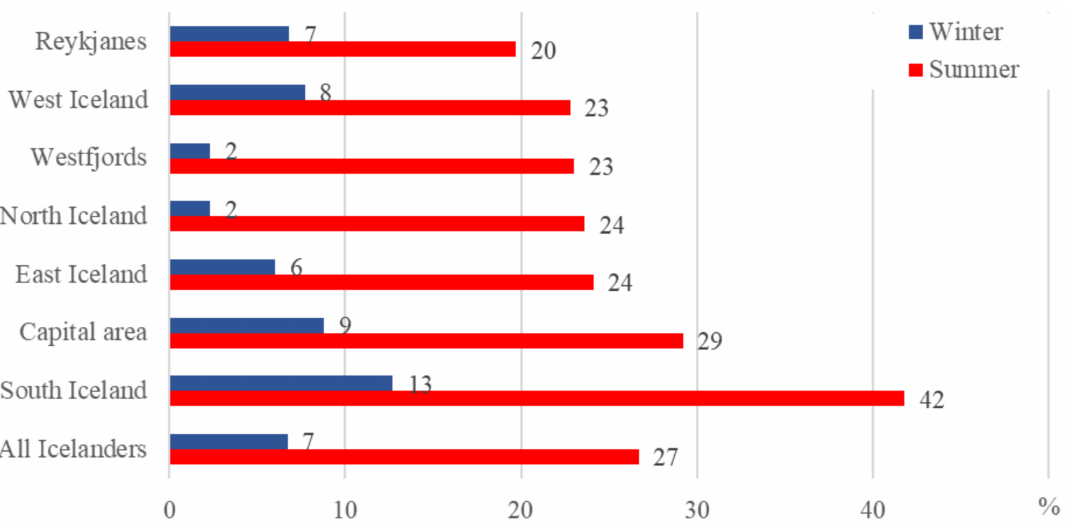
Figure 3. Proportion of residents who consider the number of visitors as too many or way too many in 2017. Derived from: